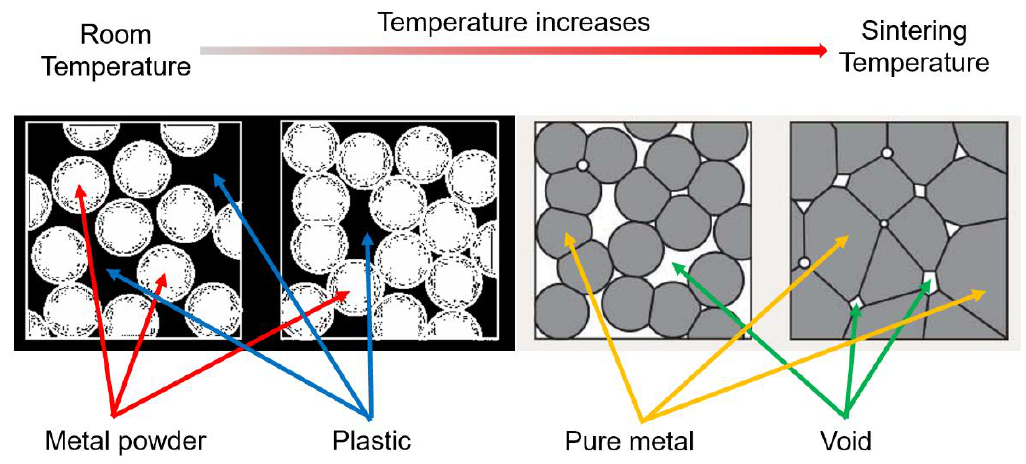
Figure 5. Sketch of sintering process .